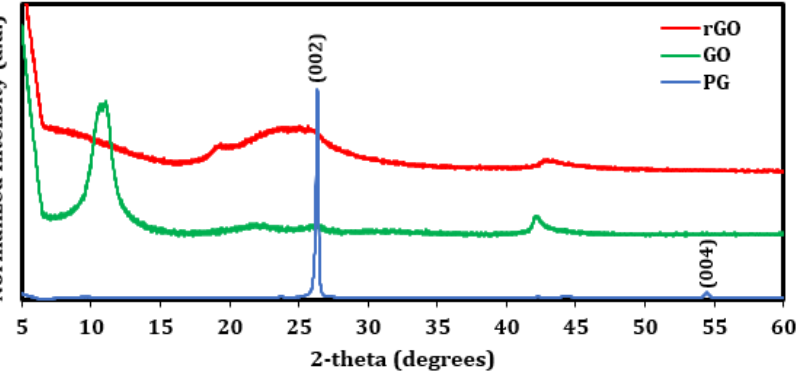
Figure 1. XRD patterns of pristine graphite (PG), synthesized graphene oxide (GO), and synthesized reduced graphene oxide (rGO). Spectra have been offset for